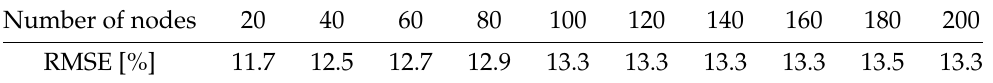
Table 4. Calculated the smallest RMSE for selected numbers of nodes in hidden layers.